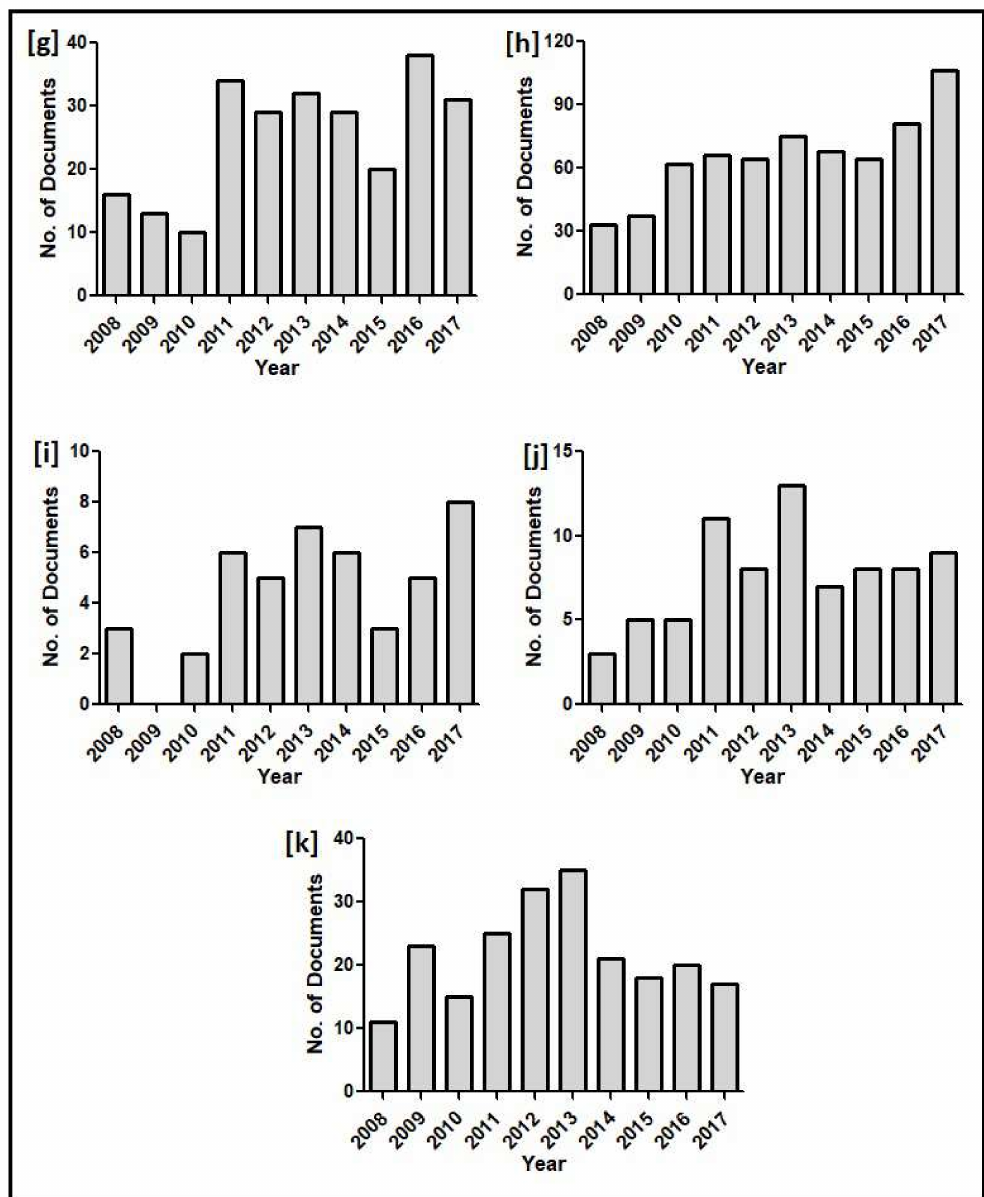
Figure 2. Annual publication history (2008–2017) of curcumin with different aging-associated diseases generated from the “Scopus” database, using the keywords ( a ) atherosclerosis-curcumin, ( b ) cancer-curcumin; ( c ) cardiovascular diseases-curcumin ( d ) chronic inflammation-curcumin; ( e ) chronic kidney diseases-curcumin; ( f ) diabetes-curcumin; ( g ) hypertension-curcumin; ( h ) neurodegenerative diseases-curcumin; ( i ) ocular diseases-curcumin; ( j ) osteoporosis-curcumin; and ( k ) rheumatoid